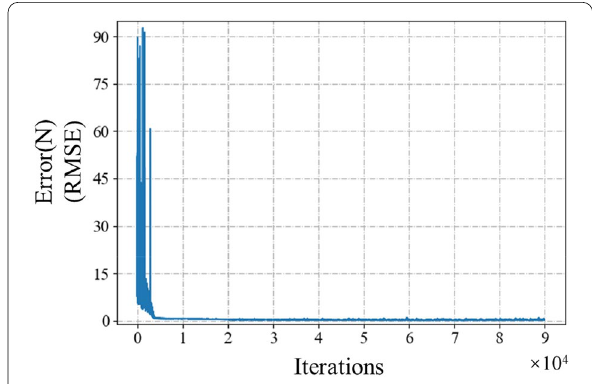
Figure 7 Convergence process with iteration solution under simulation